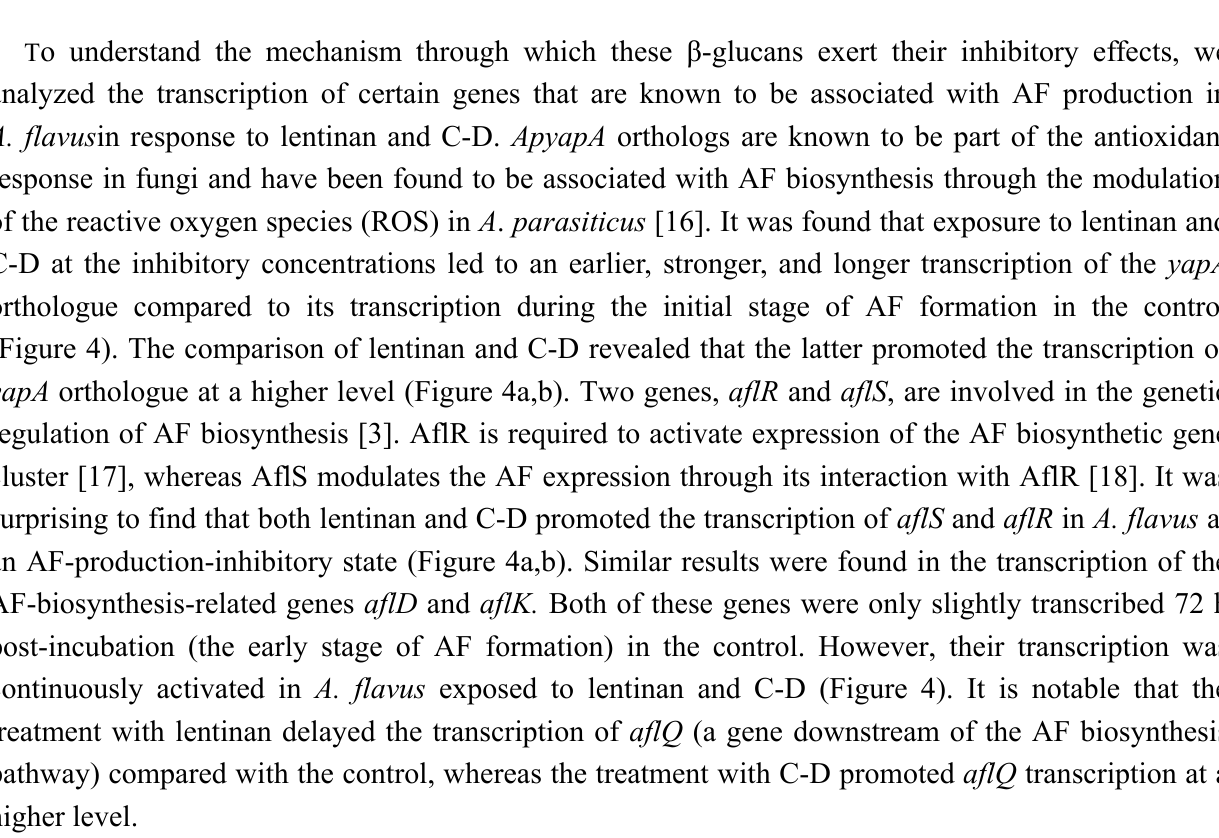
Figure 4. The transcription levels of some genes associated with aflatoxin biosynthesis in A. flavus . ( a ) The PCR products in the agarose gel, and their sizes were shown at the right; “-”: no detectable aflatoxin; ( b ) The relative gene transcription normalized on 18S rRNA level compared to control were reported. The relative abundance of the transcripts were obtained by dividing the band intensity of target gene by the band density of the corresponding 18S rRNA. The value of column equals the relative transcription of treatment minus that of